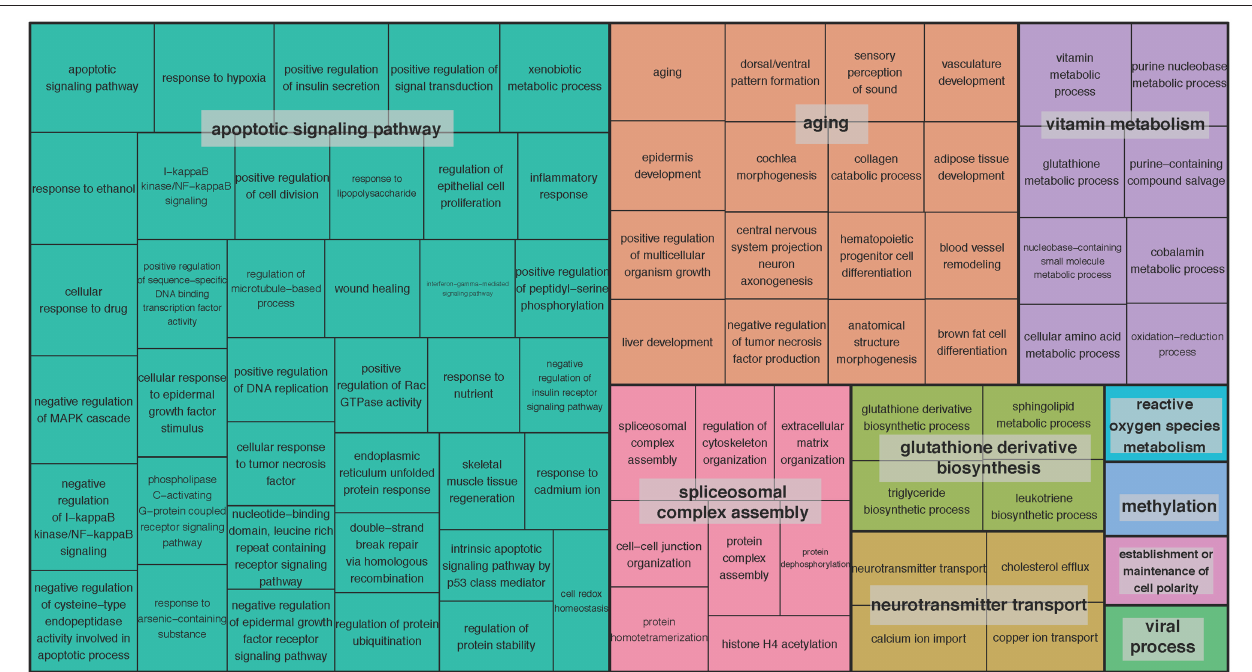
FIGURE 2 | TreeMap view of GO-term clusters for age-related genes in the brain. The TreeMap was generated by using REVIGO with the input of all GO BP terms of age-related genes detected in 13 GTEx brain regions at the FDR of 5%. Each rectangle represents a single GO-term cluster. The size of the rectangles is proportional to the frequency of the GO term in the associated GO annotation database. The cluster representatives were joined into “superclusters” of loosely related terms, visualized with different colors.